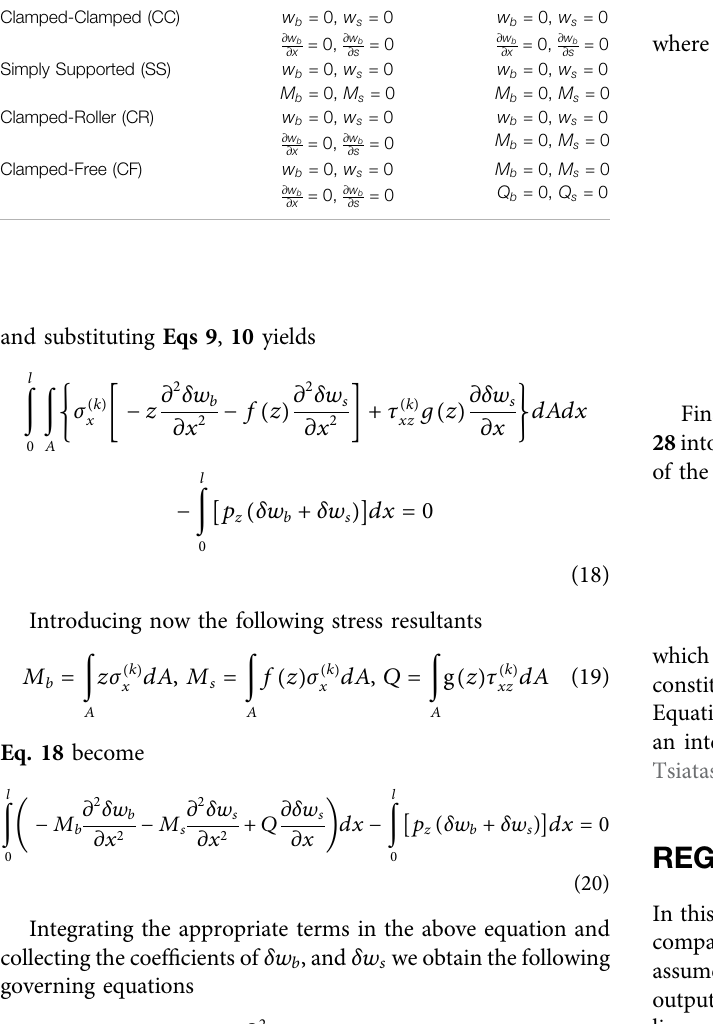
TABLE 1 | Boundary conditions examined for the prediction of the maximum de fl ection max (cid:1) w . Boundary